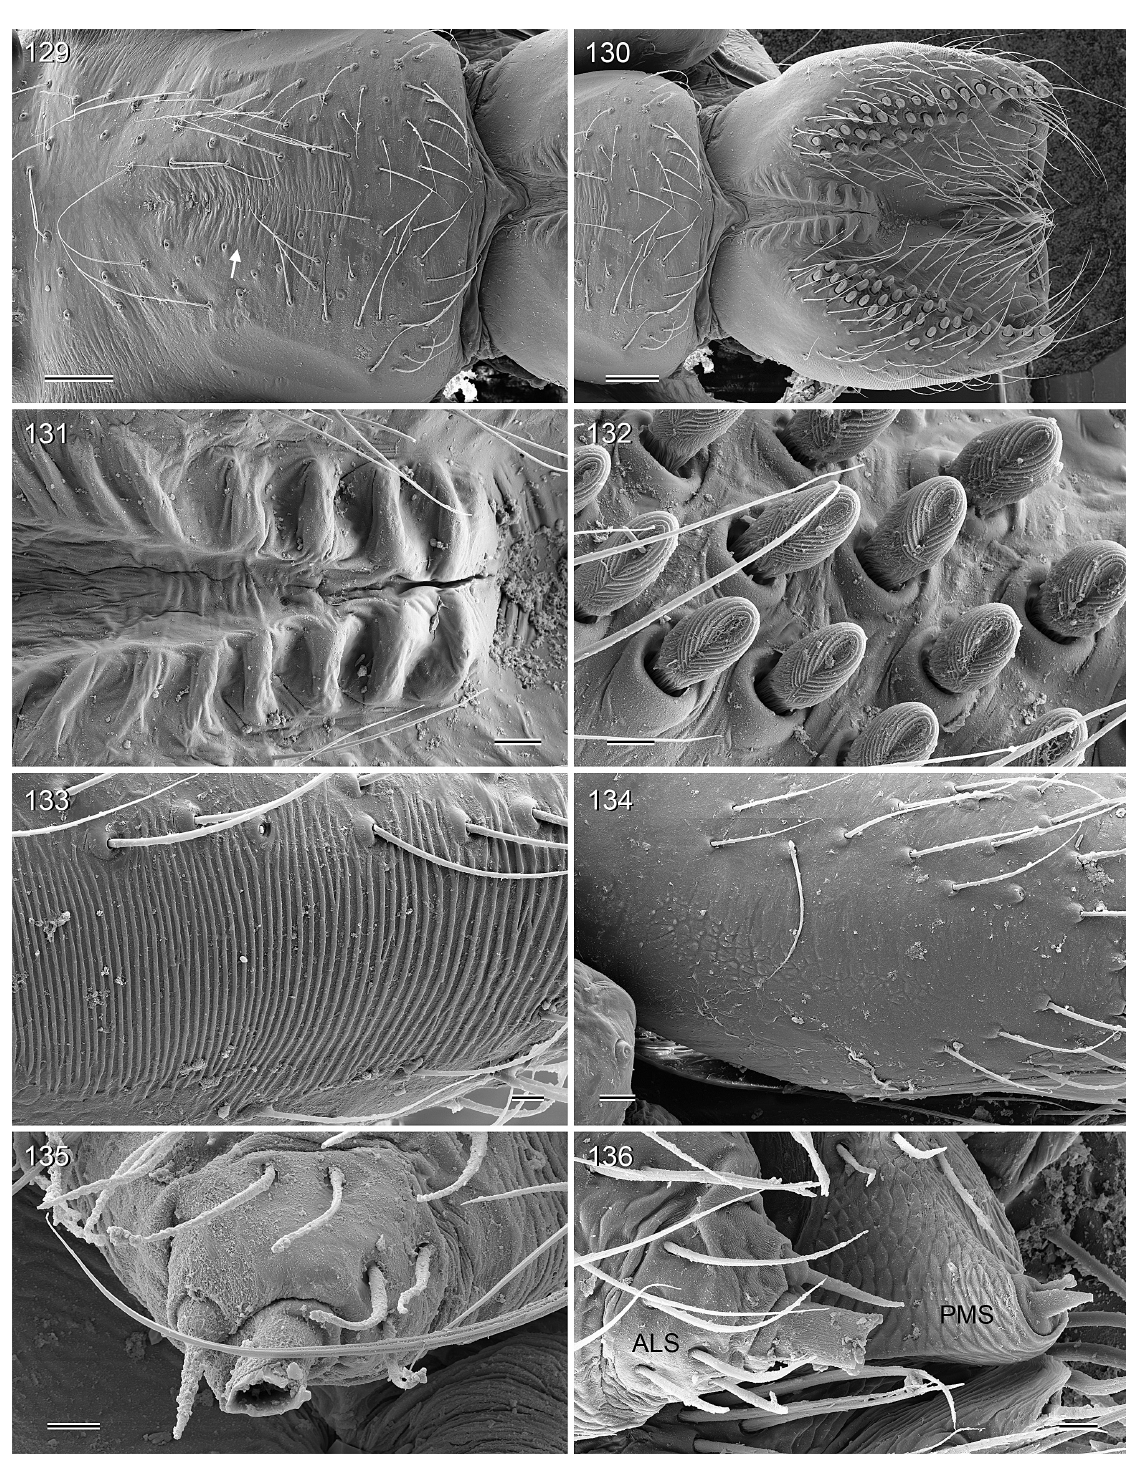
Figs 129–136. Stygopholcus photophilus Senglet, 1971; male and female from Choumerion/Pérama, Crete (MHNG). 129 . Male clypeus, frontal view; arrow points at modified median area. 130 . Male chelicerae, frontal view. 131 . Modified area medially on male chelicerae. 132 . Modified hairs frontally on male chelicerae. 133 . Stridulatory files on male chelicerae. 134 . Absence of stridulatory files on female chelicerae. 135 . Male ALS. 136 . Female anterior lateral spinneret (ALS) and posterior median spinneret (PMS). Scale bars: 129–130 = 100 µm; 131, 134–136 = 20 µm; 132–133 = 10